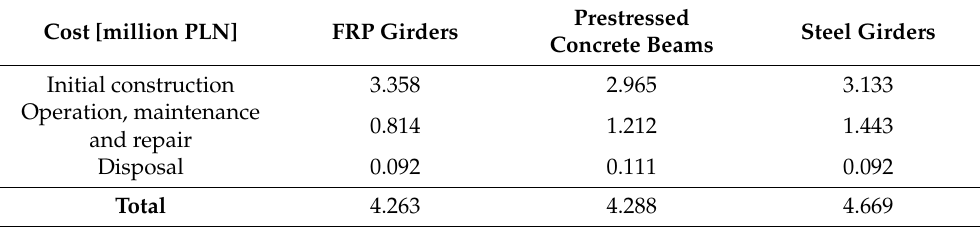
Table 2. Comparison of construction, maintenance and demolition costs of different types of bridges